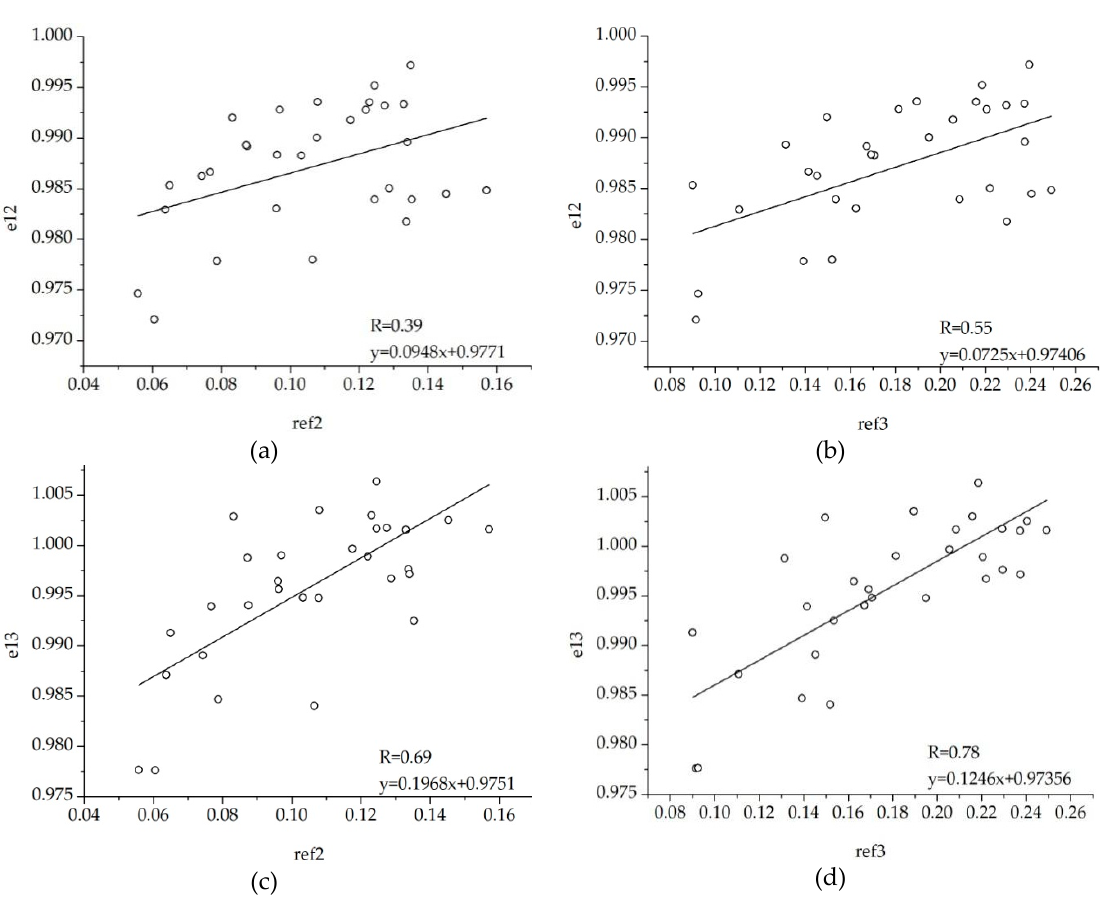
Figure 4 . Correlation analysis between measured channel emissivity and reflectance, where ( a ) is the correlation analysis between e12 and ref2, ( b ) is the correlation analysis between e12 and ref3, ( c ) is the correlation analysis between e13 and ref2, and ( d ) is the correlation analysis between e13 and